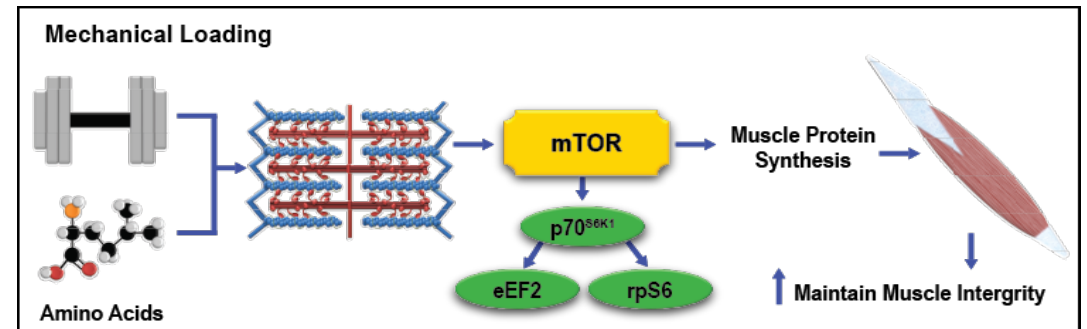
Figure 3. Simplified illustration of the combined effects of mechanotransduction and amino acid-mediated anabolic signaling on skeletal muscle